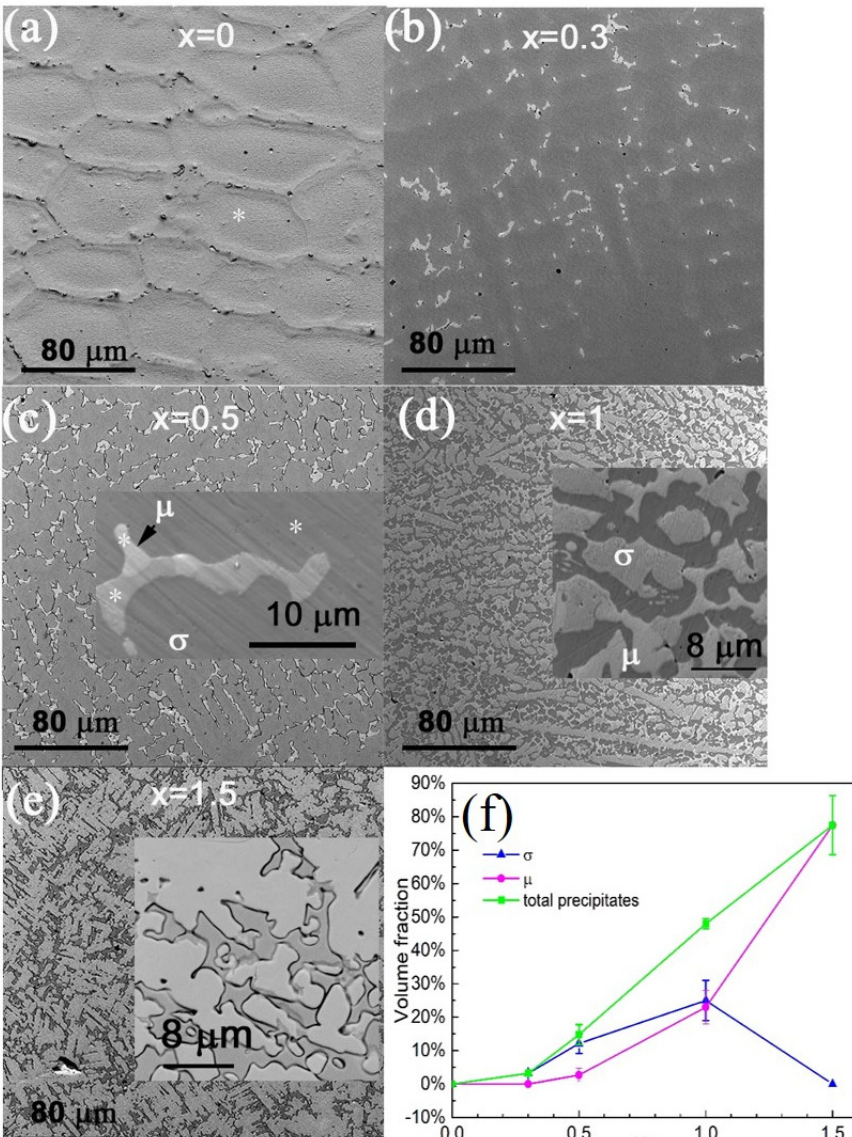
Figure 3. SEM backscattering images of the as-cast Mox high entropy alloys: ( a ) For Mo0, ( b ) for Mo0.3, ( c ) for Mo0.5, ( d ) for Mo1, ( e ) for Mo1.5, and ( f ) the variation of the volume fraction of the precipitates with the Mo molar ratio.